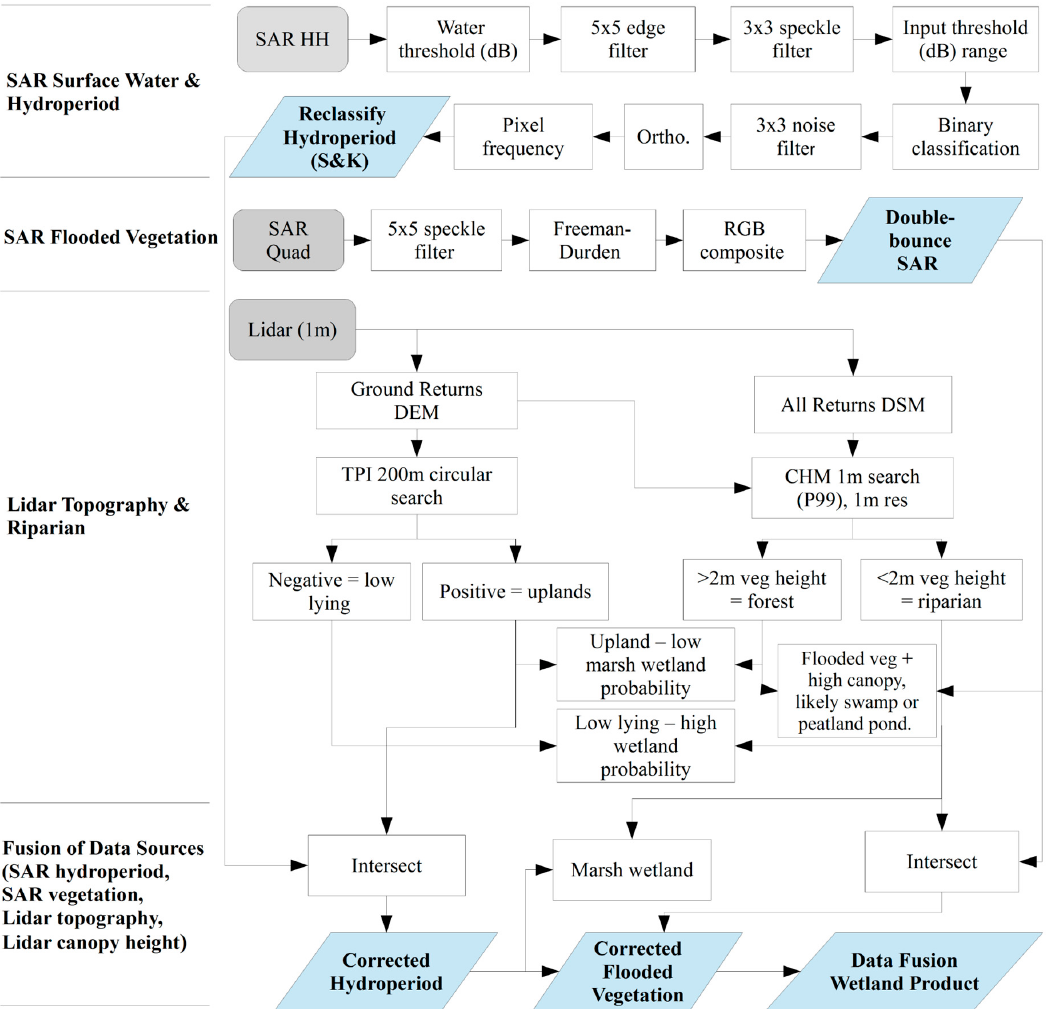
Figure 2. Decision-based data fusion workflow of four primary products (SAR surface water masks, SAR flooded vegetation layer, topographic position index from DEM, and vegetation from CHM).